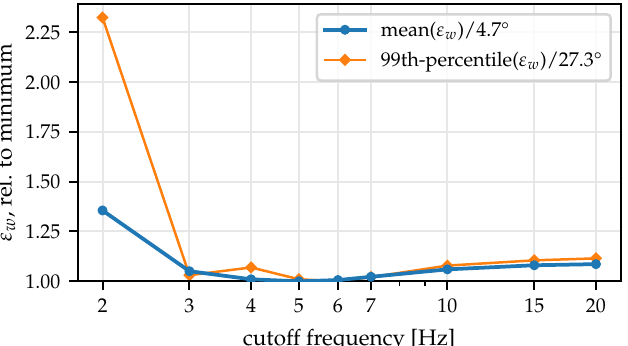
Figure A1. Variability of the obtained axis estimates (mean and 99th-percentile of ε w , relative to minimum value) for different values of the cutoff frequency of the soft tissue motion artifact reduction low pass filter. Low-pass filtering of the angular rates increases the consistency of the axis estimates, but for too low cutoff frequencies, important information is lost, and the deviations increase. Choosing a cutoff frequency of 5Hz gives robust